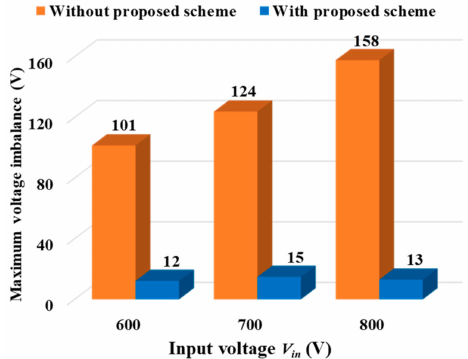
Figure 13. Comparison of the drain-source voltage of series-connected switches at di ff erent input voltages: ( a ) without the proposed scheme; ( b ) with the proposed scheme.